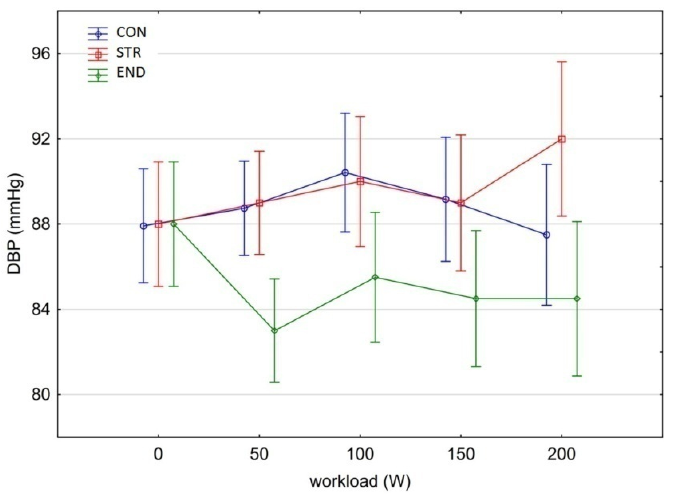
Figure 5. Mean values ± 95% CI of diastolic blood pressure (DBP) at rest and its response during the progressive exercise test.